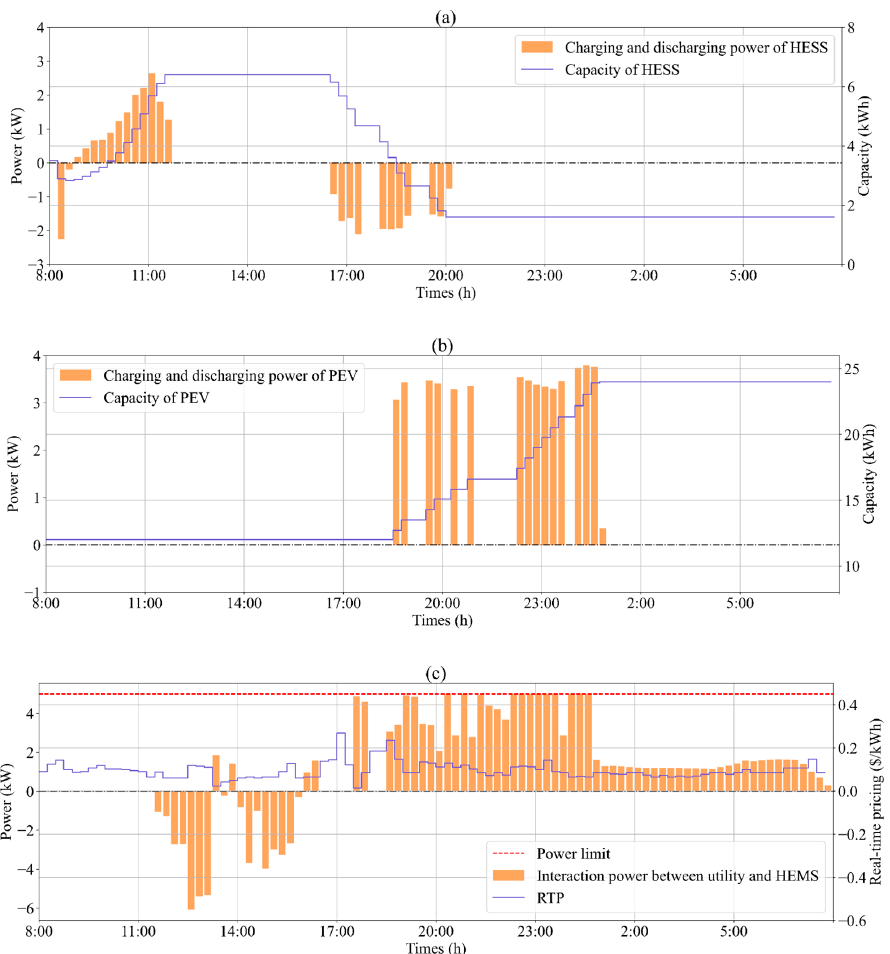
Figure 11. Load profiles for ( a ) HESS in HESS2H mode, ( b ) PEV in G2V mode, and ( c ) H-MG without mode segmentation strategy.